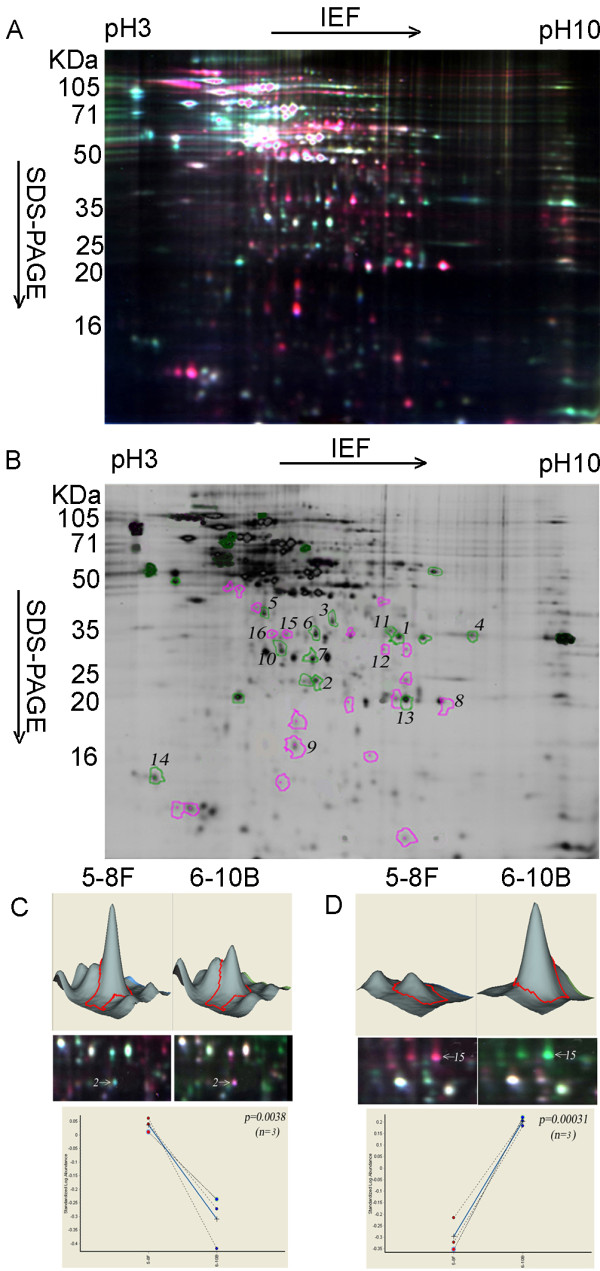
2D-DIGE analysis of metastatic 5-8F versus nonmetastatic 6-10B cells. A. A representative two-color merged 2D-DIGE gel image. Green is the Cy3-labeled metastatic 5-8F cell sample. Red is the Cy5-labeled 6-10B cell sample. B. Labeled differentially expressed proteins (DEPs) between metastatic (5-8F) and nonmetastatic (6-10B) cell mitochondria (Ratio = 5-8F/6-10B; Red: down-regulated; Green: up-regulated). C. Three-dimensional simulation, a close-up of the region of 2D-DIGE gel image, and the associated graph view of a representative up-regulated protein in metastatic 5-8F cell mitochondria (spot 2). D. Three-dimensional simulation, a close-up of the region of 2D-DIGE gel image, and the associated graph view of a representative down-regulated protein in metastatic 5-8F cell mitochondria (Spot 15).